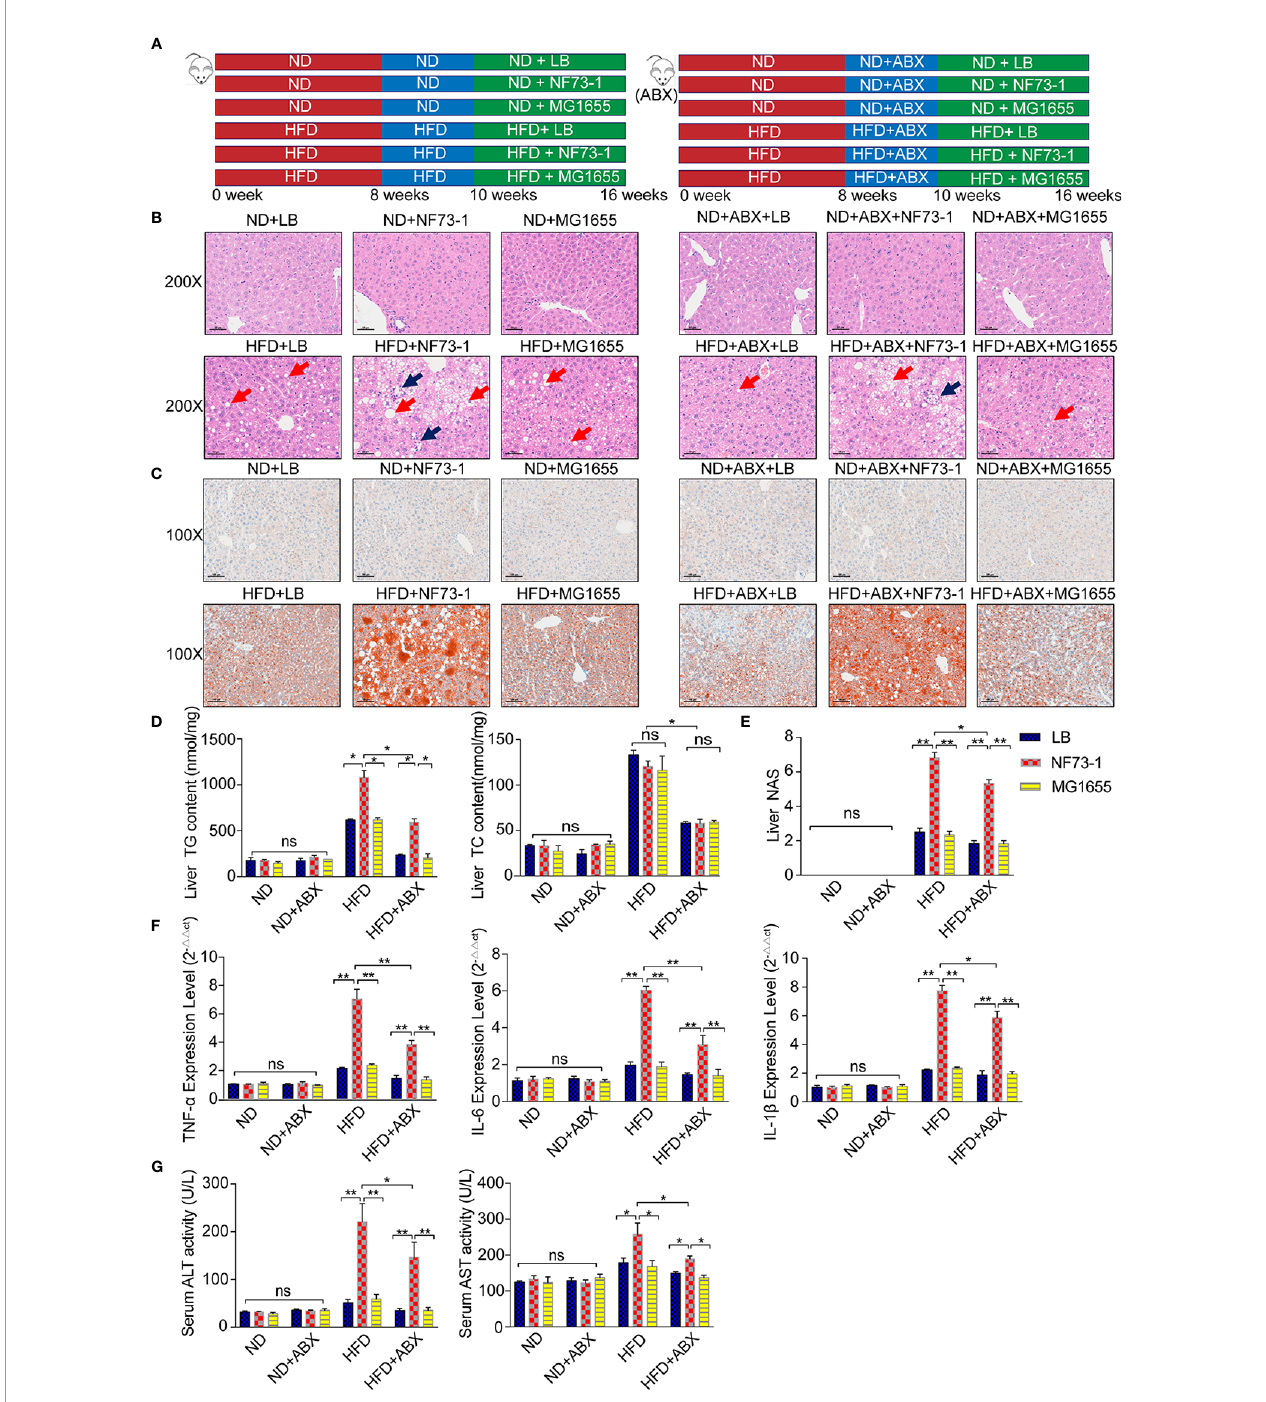
FIGURE 2 | Liver injury enhancement in NAFLD mice with E. coli NF73-1. (A) Schematic diagram showing the overall design and complete timeline for model construction. (B) Representative images of H&E-stained mouse liver (blue arrows, in fl ammatory cells; red arrows, steatosis); scale bar indicates 50 m m. (C) Oil Red O-stained liver images; scale bar indicates 100 m m. (D) Hepatic triglyceride and cholesterol content and their concentrations in serum in each group. (E) NAS analysis of the liver. (F) TNF- a , IL-6, and IL-1 b content in the liver in each group. (G) Serum ALT and AST activity in each group. Data are calculated as the mean ± SEM, n = 6 – 8 per group. ns p>0.05, *p <0.05, **p <0.01 (unpaired t test). NAFLD, non-alcoholic fatty liver disease; ABX, broad-spectrum antibiotics complex; ALT, alanine aminotransferase; AST, aspartate aminotransferase; TC, total cholesterol; TG, total triglyceride; H&E, hematoxylin & eosin; NAS, NAFLD activity score; TNF- a , tumor necrosis factor a ; IL-6, interleukin 6; IL-1 b , interleukin 1 b ; ND, normal diet; HFD, high-fat diet; NS, no signi fi